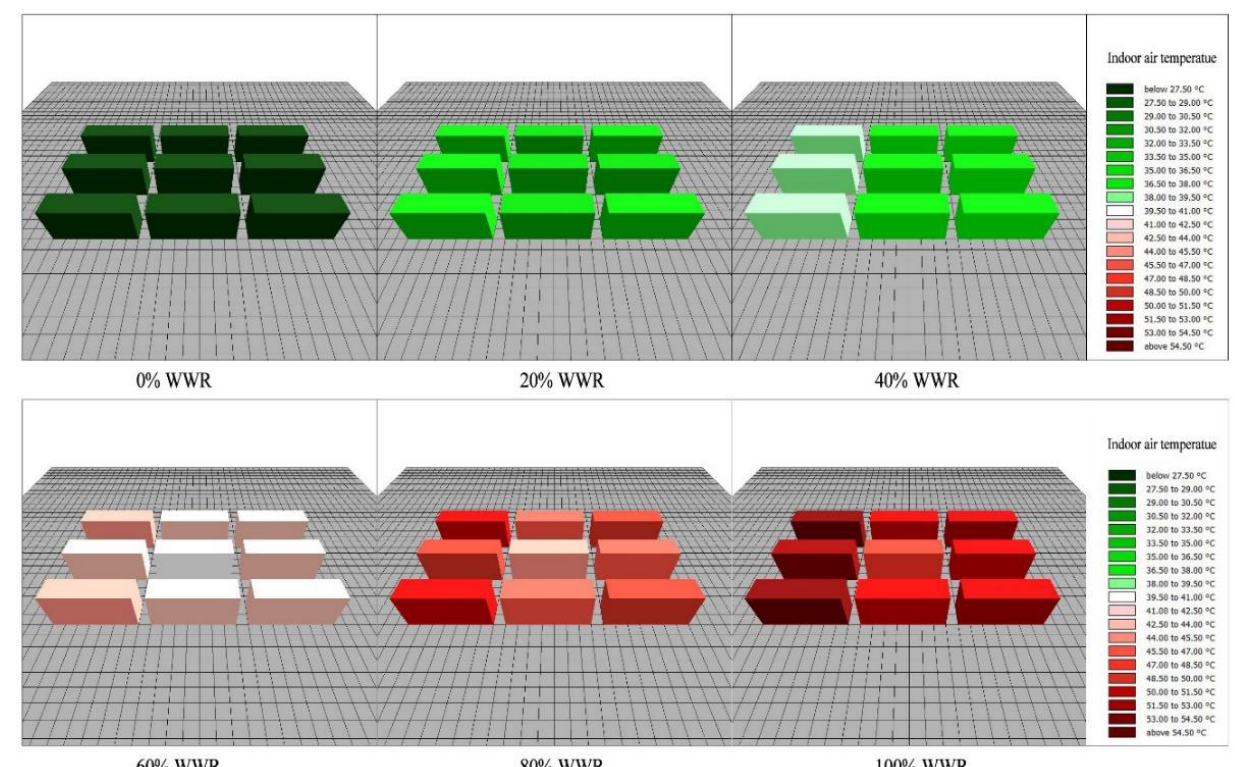
Figure 9. A sample of simulated indoor air temperatures.